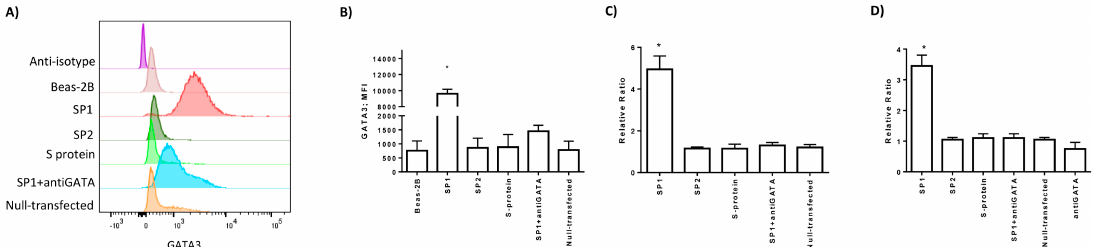
Figure 4. ( A ) Representative histograms of GATA3 expression on the surface of Beas-2B cells after transfection with SP1, SP2, and S proteins or control fluorescent antibody was used as a positive control (null-transfected) or treated with GATA inhibitor (anti-GATA). ( B ) The histograms showed the mean ± standard deviation MFI (mean fluorescence intensity) values of GATA3 expression in three independent experiments. * significant p values Student t test. ( C ) Relative ratio of real-time PCR of GATA3 expression in transfected Beas-2B cells. SP1-transfected Beas-2B cells were also treated with GATA inhibitor (anti-GATA). ( D ) Relative ratio of real-time PCR of GATA3 target gene Eotaxin3 / CCL26 in transfected Beas-2B cells. SP1-transfected Beas-2B cells were also treated with GATA inhibitor (anti-GATA). * significant p values Student t